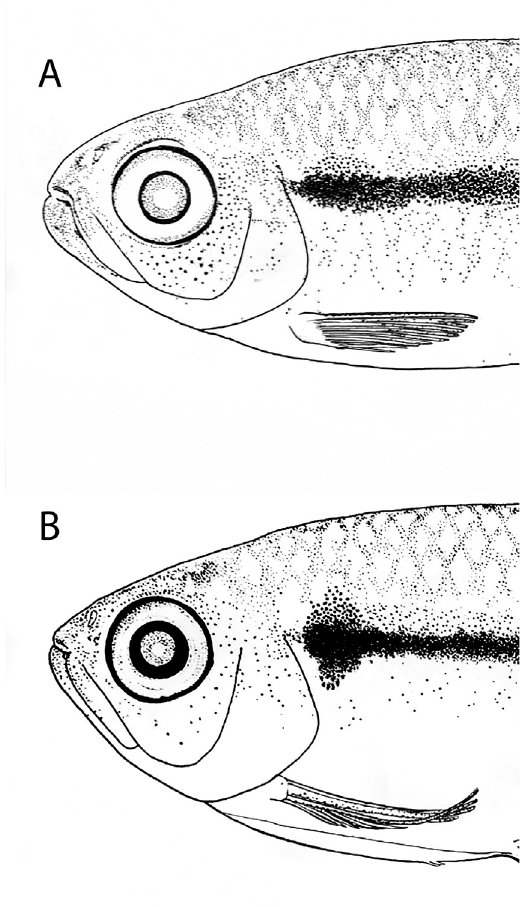
FIGURE 5 | Schematic representation of humeral blotch and anterior portion of midlateral stripe between Hyphessobrycon cantoi ( A , ZUEC 14597, paratype 32.1 mm SL, rio Amazonas basin) and H. heterorhabdus ( B , INPA 41126, 27.8 mm SL, rio Curuá-Una